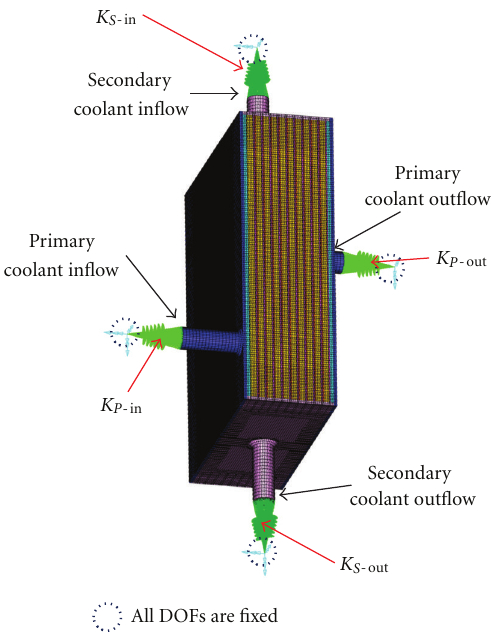
Figure 8: Boundary conditions for a structural